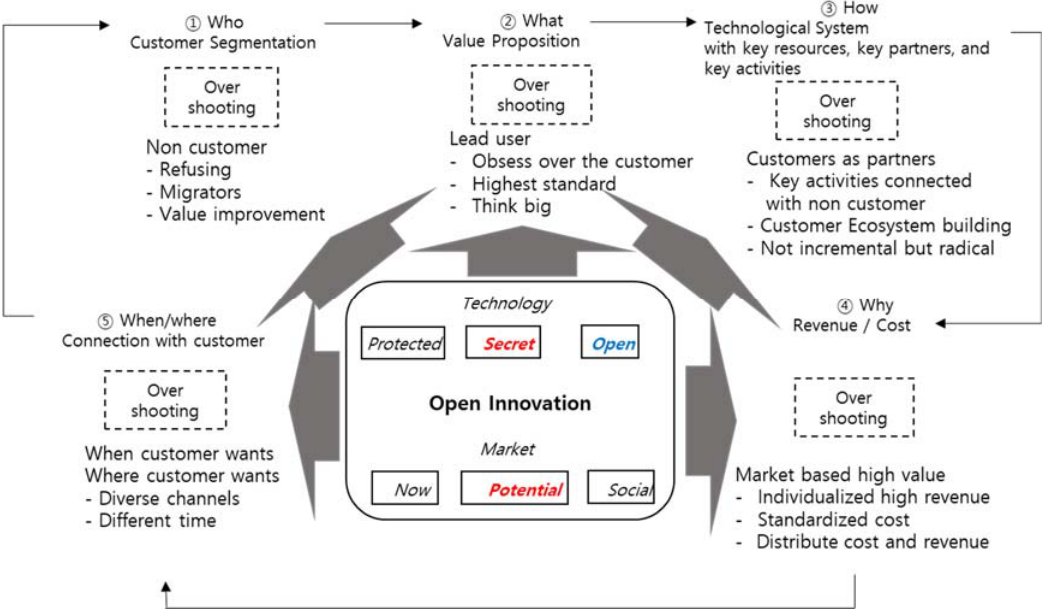
Figure 3. Overshooting rectangular concept model for customer ‐ centered business model innovation.